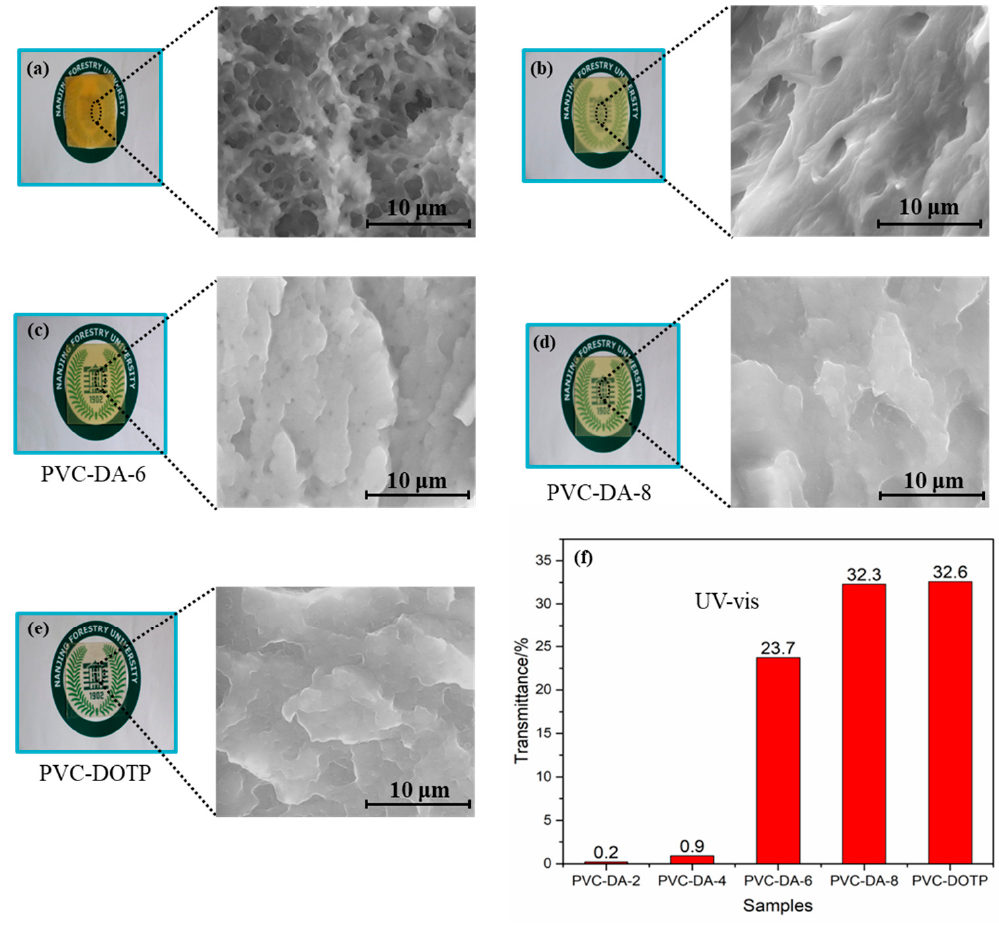
Figure 6. Photographs, SEM images ( a – e ), and the UV ‐ vis transmittance (f, at a wavelength of 500 nm) of PVC ‐ DA ‐ 2n (2n = 2, 4, 6, 8) and PVC ‐ DOTP.